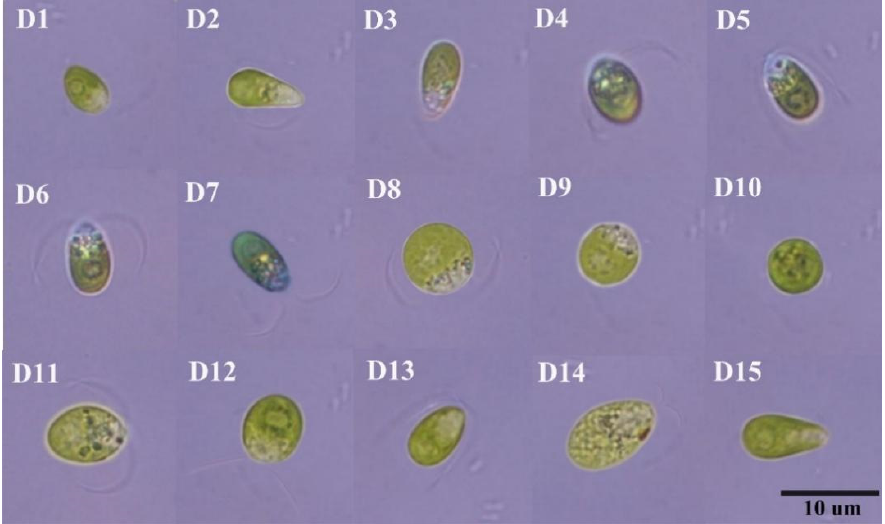
Figure 2. Algal cell morphology of the 15 species of Dunaliella (100×). Table 4. Description of the cell characteristics of the 15 Dunaliella species. The length/width of the cell is used as a single factor for single-factor analysis of variance, and the results are represented by A and